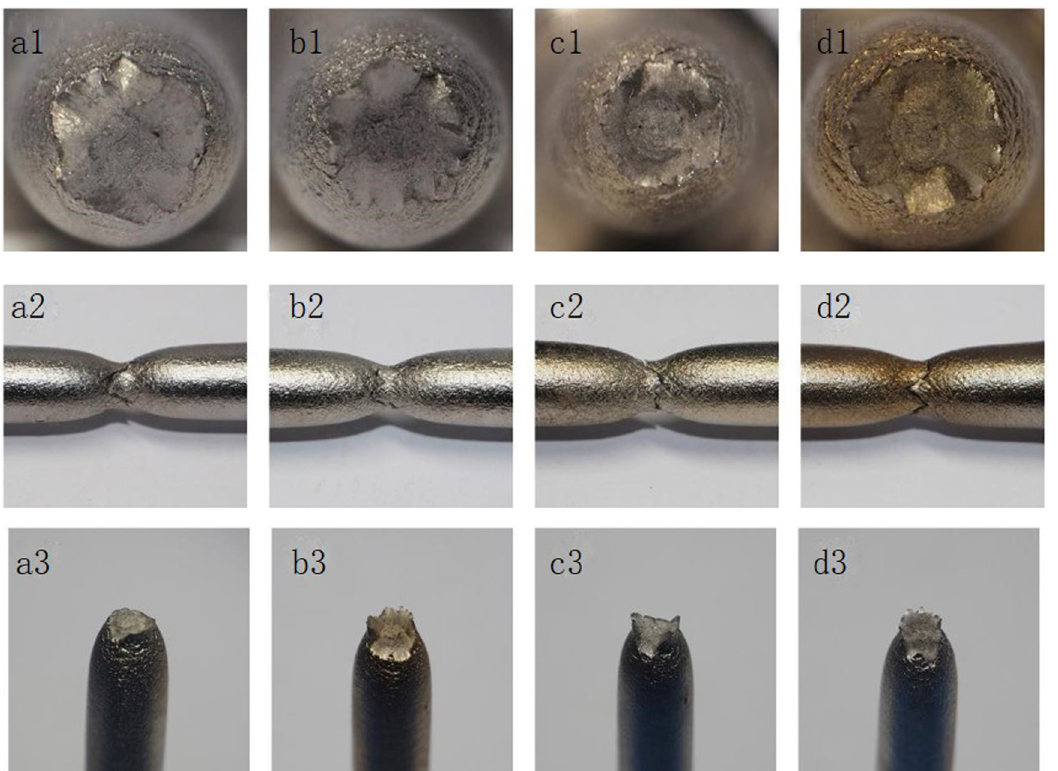
Figure 8: Macroscopic morphology of fracture of 304 steel after high - temperature tensile test: ( a ) 25°C, ( b ) 150°C, ( c ) 250°C, and ( d ) 350°C.